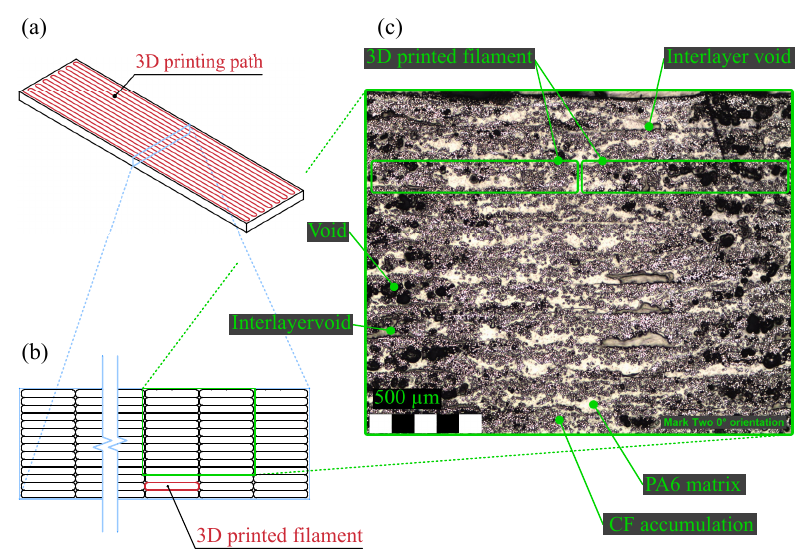
Figure 6. Microstructure of a 3D printed CF/PA6 specimen. ( a ) illustrates the printing path and the cross-section location, shown in ( b ), where the layer-wise specimen structure is visible. A layer consists of multiple filaments deposited next to each other. The micrograph’s location is shown in ( c ). Areas with interlayer voids, other voids, pure matrix, and irregular fiber distribution are visible.